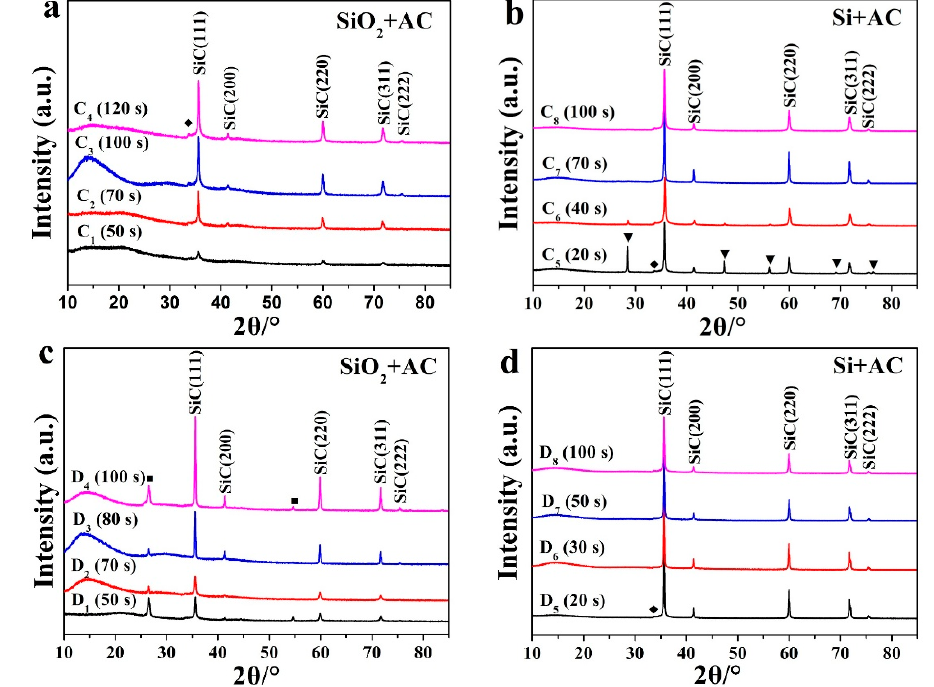
Figure 3. XRD patterns of β -SiC samples synthesized in CMMC reactor. Reflections from silicon ( ▼ ), graphite ( ■ ) and stacking faults in β -SiC ( ◆ ) are indicated. Microwave susceptor: ( a , b ) AC and ( c , d ) graphite.